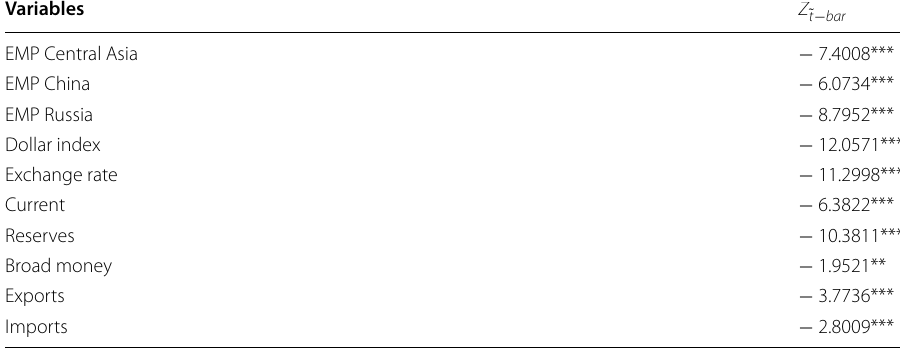
Table 2 Unit root test (IPS,